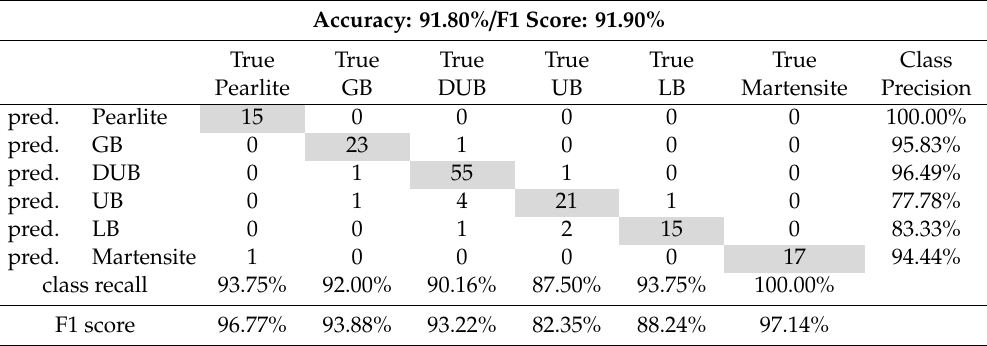
Table 7. Confusion matrix for the classification using a combination of Haralick parameters and multi-scale local binary pattern with a quadratic kernel SVM, after removing correlative